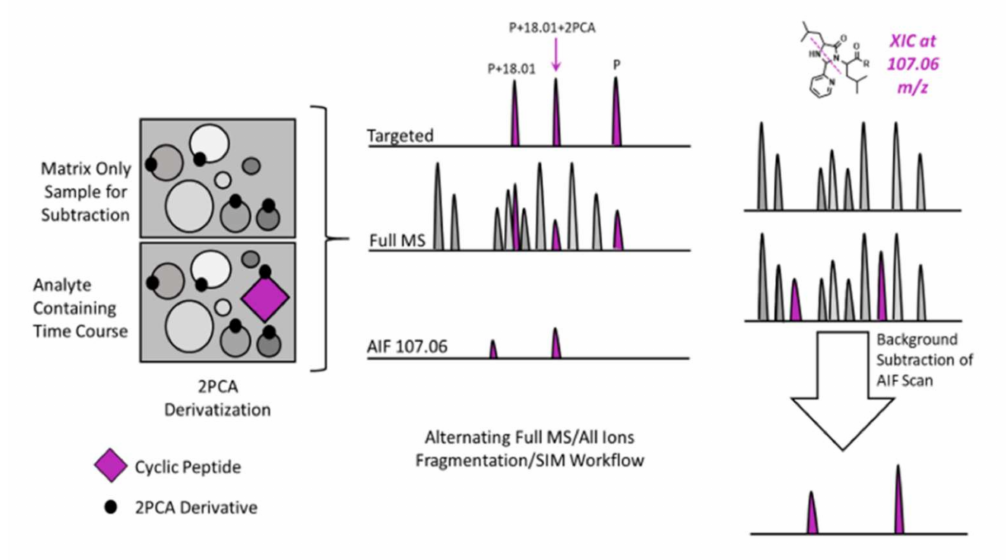
Figure 3. A cartoon representation of the workflow utilized for semi-automated SSID of a com- mercially available cyclic peptide, JB1. Analyte containing samples and matrix only controls were subjected to MS analysis with unscheduled PRM analysis (for the parent, hydrolyzed parent, and hydrolyzed parent modified by 2PCA), full MS with DDA, and AIF for unbiased observation of the diagnostic imidazolidinone peak. Background subtraction was then performed on the AIF scans to identify analyte-specific 2PCA